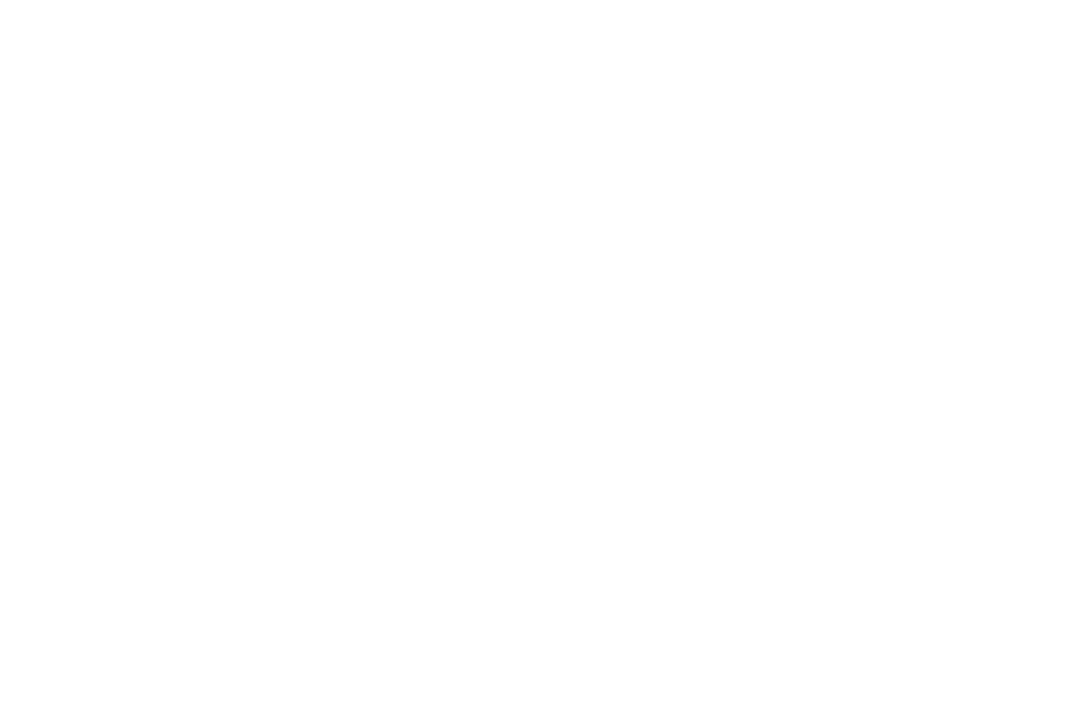
Frontiers in Earth Science |